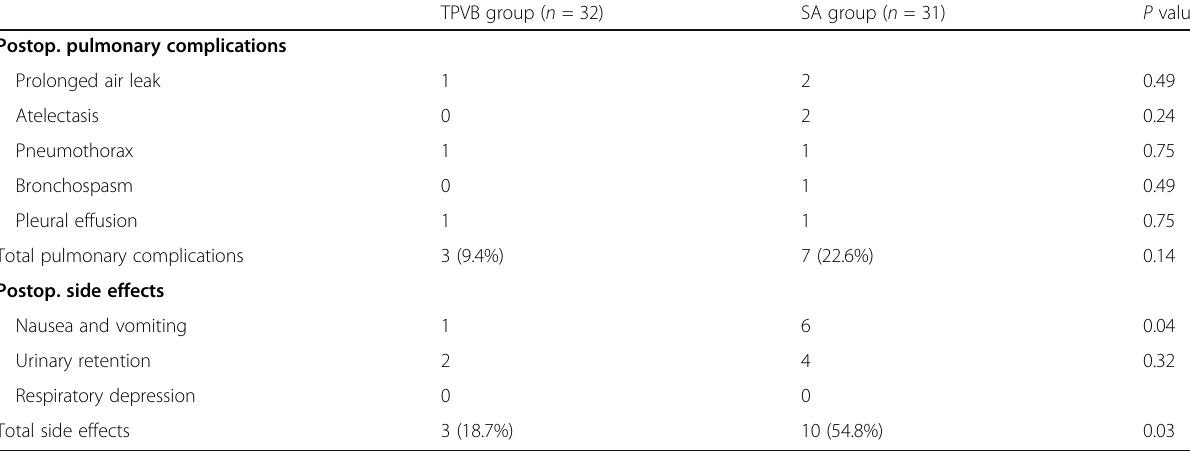
Table 6 Postoperative complications and side